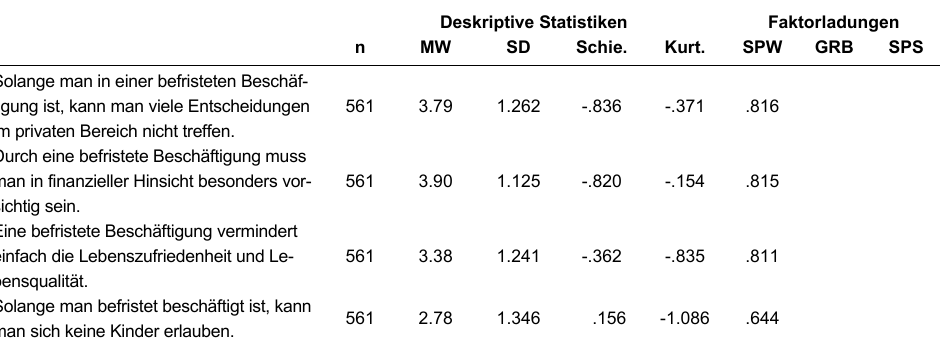
Tabelle 2: Faktoren- und Reliabilitätsanalysen zu den Skalen Subjektive Prekaritätswahrnehmung (SPW), Geschlechterrollenbilder (GRB) und Subjektive Partnerschaftsstabilität